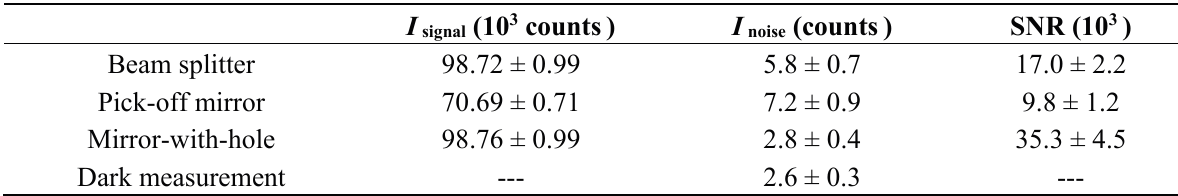
Table 1. Comparison of the influence of fluorescence from a dichroic beam splitter, and its replacement alternatives, on the signal-to-background-noise ratio (SNR) of capillary Raman